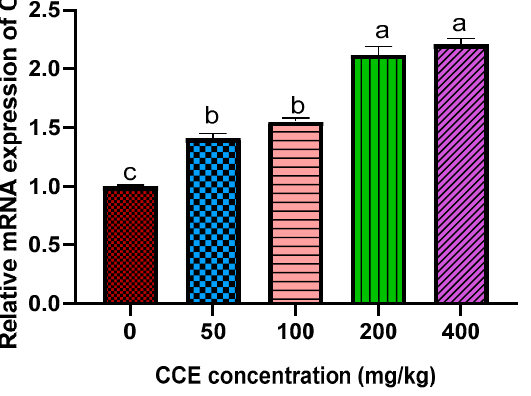
dismutase, ( SOD ) ( B ) and catalase, ( CAT ) ( C ). a–e Means with a row carrying different superscripts are significantly different